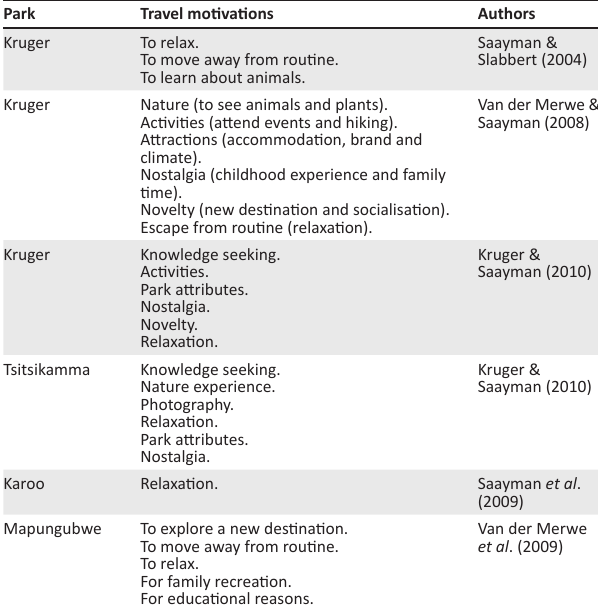
TABLE 1: Travel motivations to national